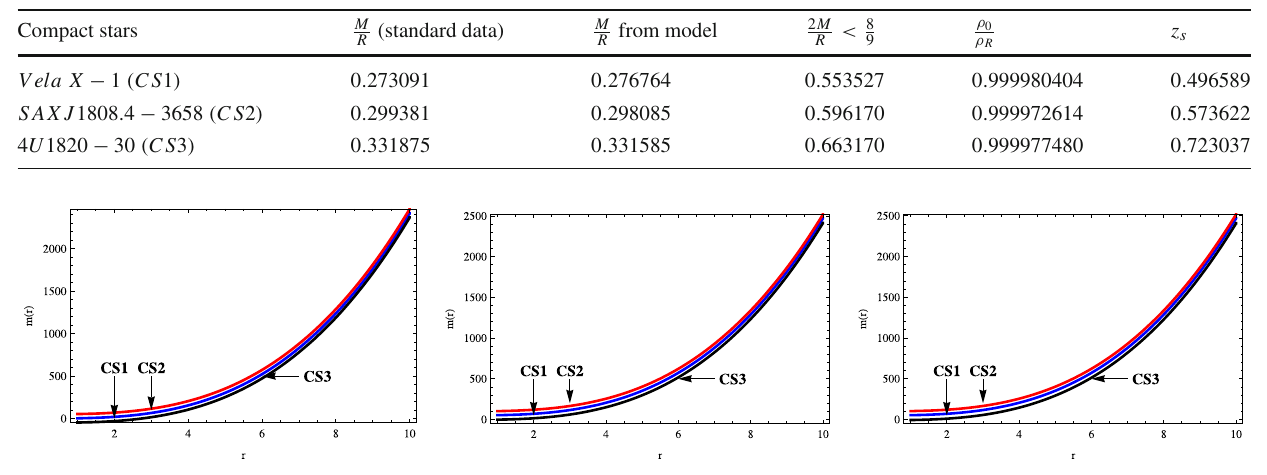
Fig. 18 Variations of m ( r ) versus r (km) with the numerical values of A , B and C from Tables 1, 2 and 3 respectively